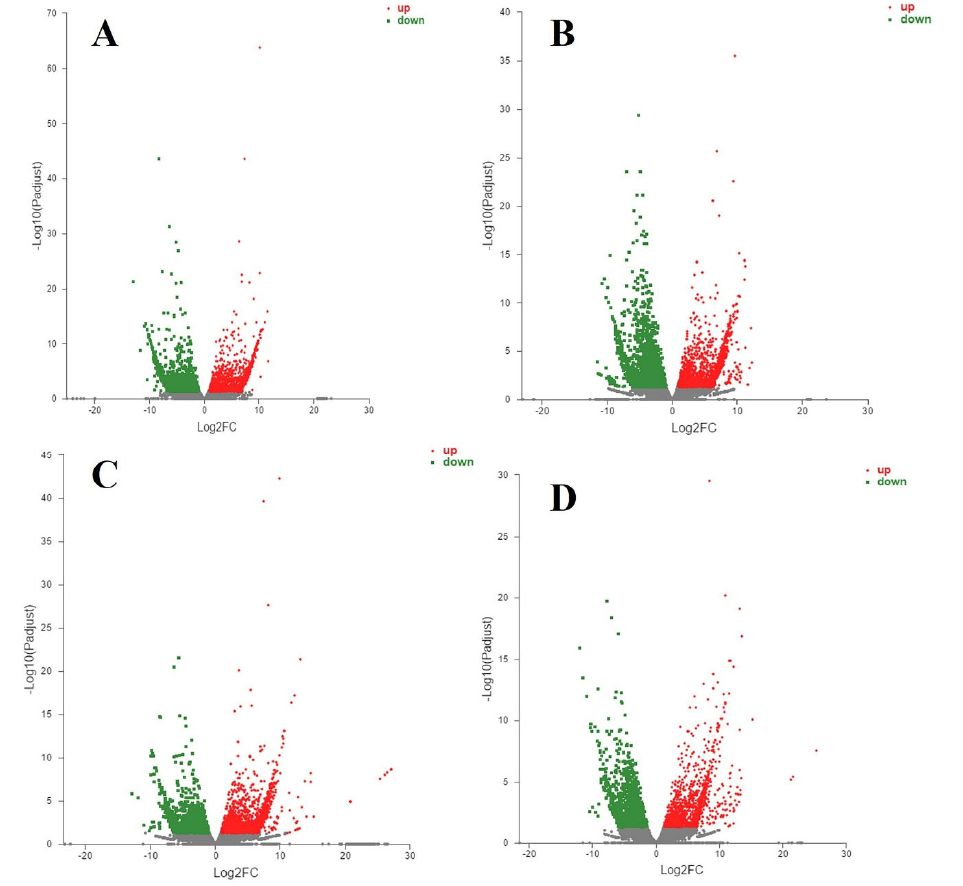
Figure 6. Volcano map of differentially expressed genes (DEGs) of hybrid triploid loaches at ( A ) 4 dph, ( B ) 15 dph, ( C ) 22 dph, and ( D ) 50 dph.